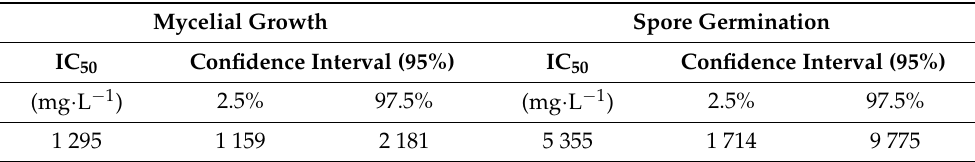
Table 4. Half maximal inhibitory concentration (IC 50 ) values of essential oil from hop cones on P. infestans mycelial growth and spore germination. Mycelial Growth Spore Germination IC 50 Confidence Interval (95%) IC